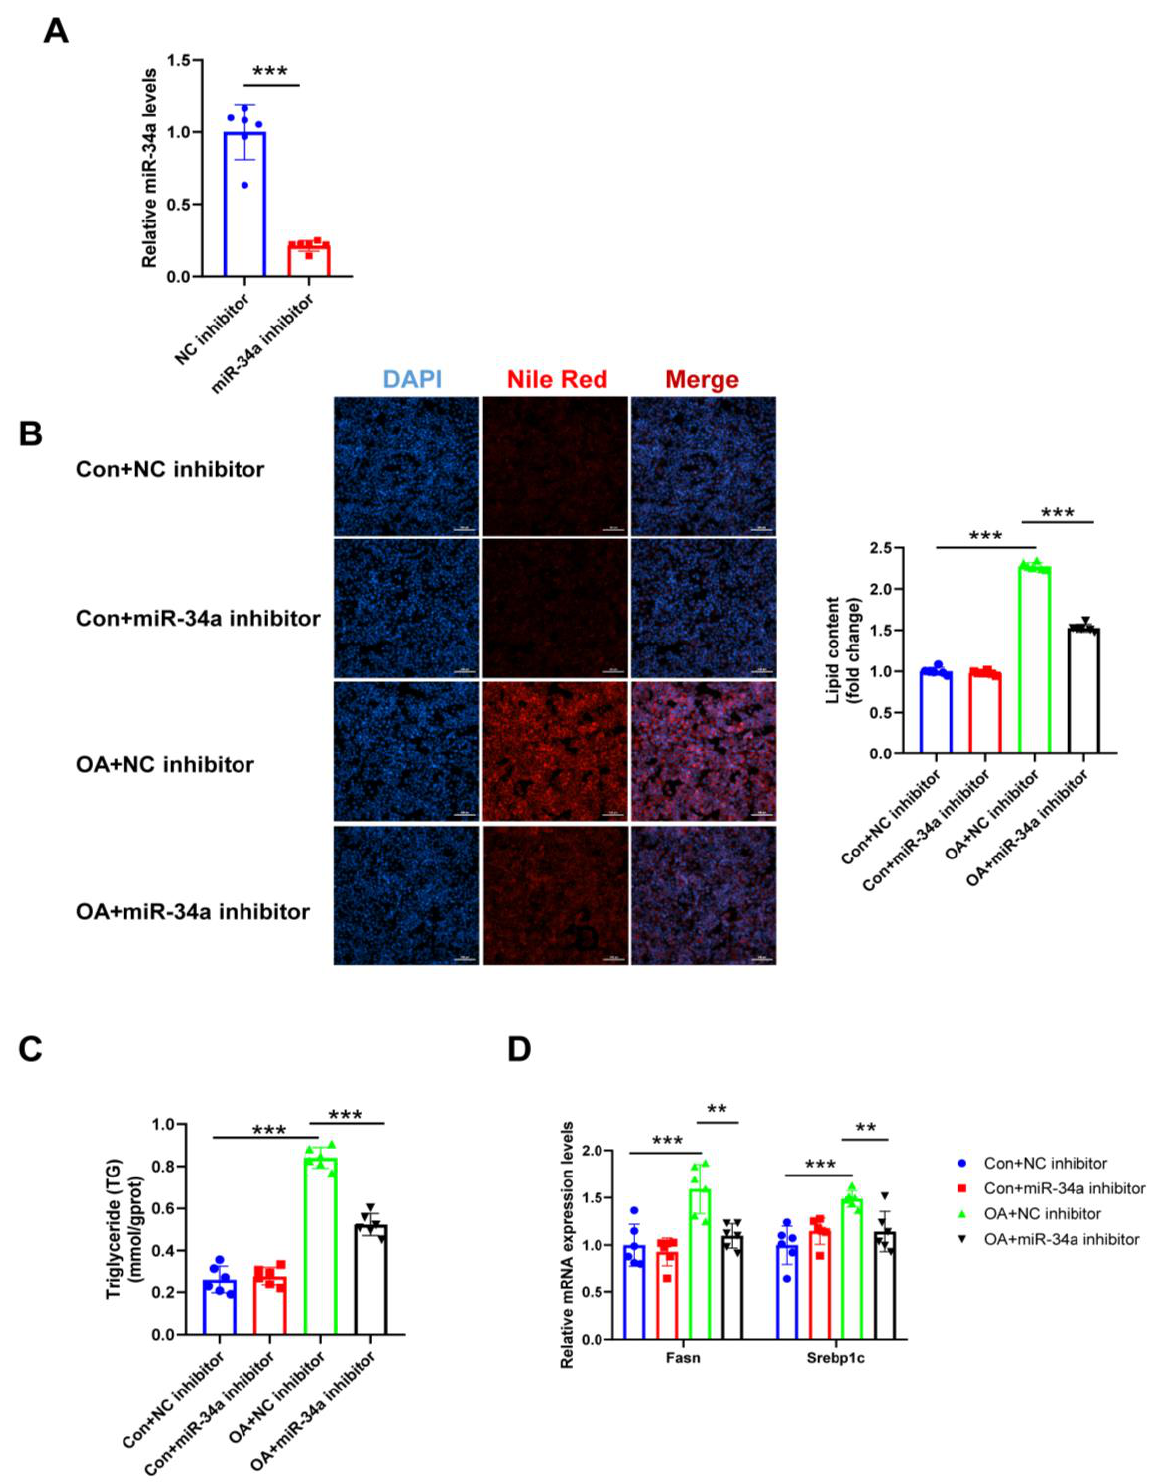
Figure 7. Effects of miR-34a inhibitor on lipogenesis in hepatocytes. ( A ) The expression levels of miR-34a relative to U6 were analyzed by qRT-PCR after transfection with miR-34a inhibitor in HepG2 cells. ( B ) The lipid content of HepG2 cells was determined by Nile Red staining. ( C ) The TG levels of HepG2 cells. ( D ) The mRNA levels of lipogenesis-related genes (Fasn and Srebp1c) relative to GAPDH were analyzed by qRT-PCR. ** p < 0.01, *** p < 0.001; n = 6. OA, oleic acid; TG, triglyceride; Fasn, fatty acid synthase; Srebp1c, sterol regulatory element binding protein-1c. Scale bar = 100 µ